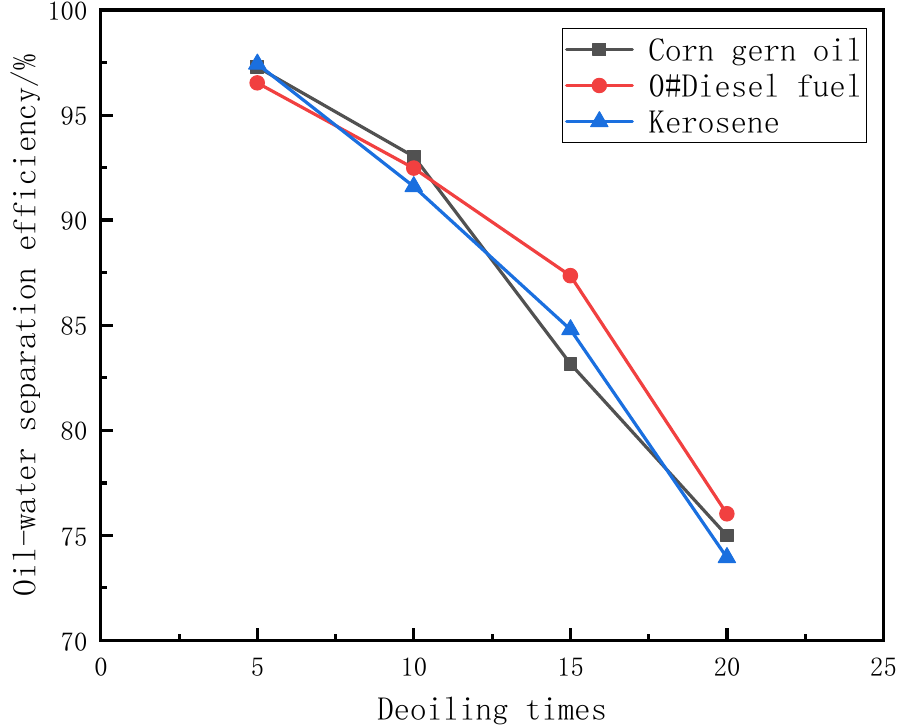
Figure 10. Oil-water separation efficiency after multiple cycles of PDMS@Fe 3 O 4 Figure 10. Oil ‐ water separation efficiency after multiple cycles of PDMS@Fe 3 O 4 /MS.